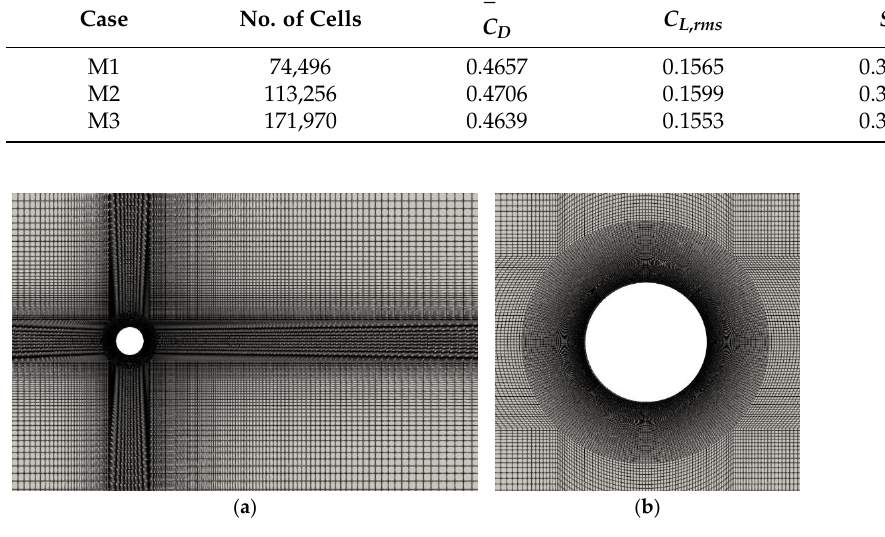
Figure 2. Example of the mesh M2 ( a ) an overall view and ( b ) a zoom-in view of the mesh close to the cylinder. Table 1. Results of grid convergence study.